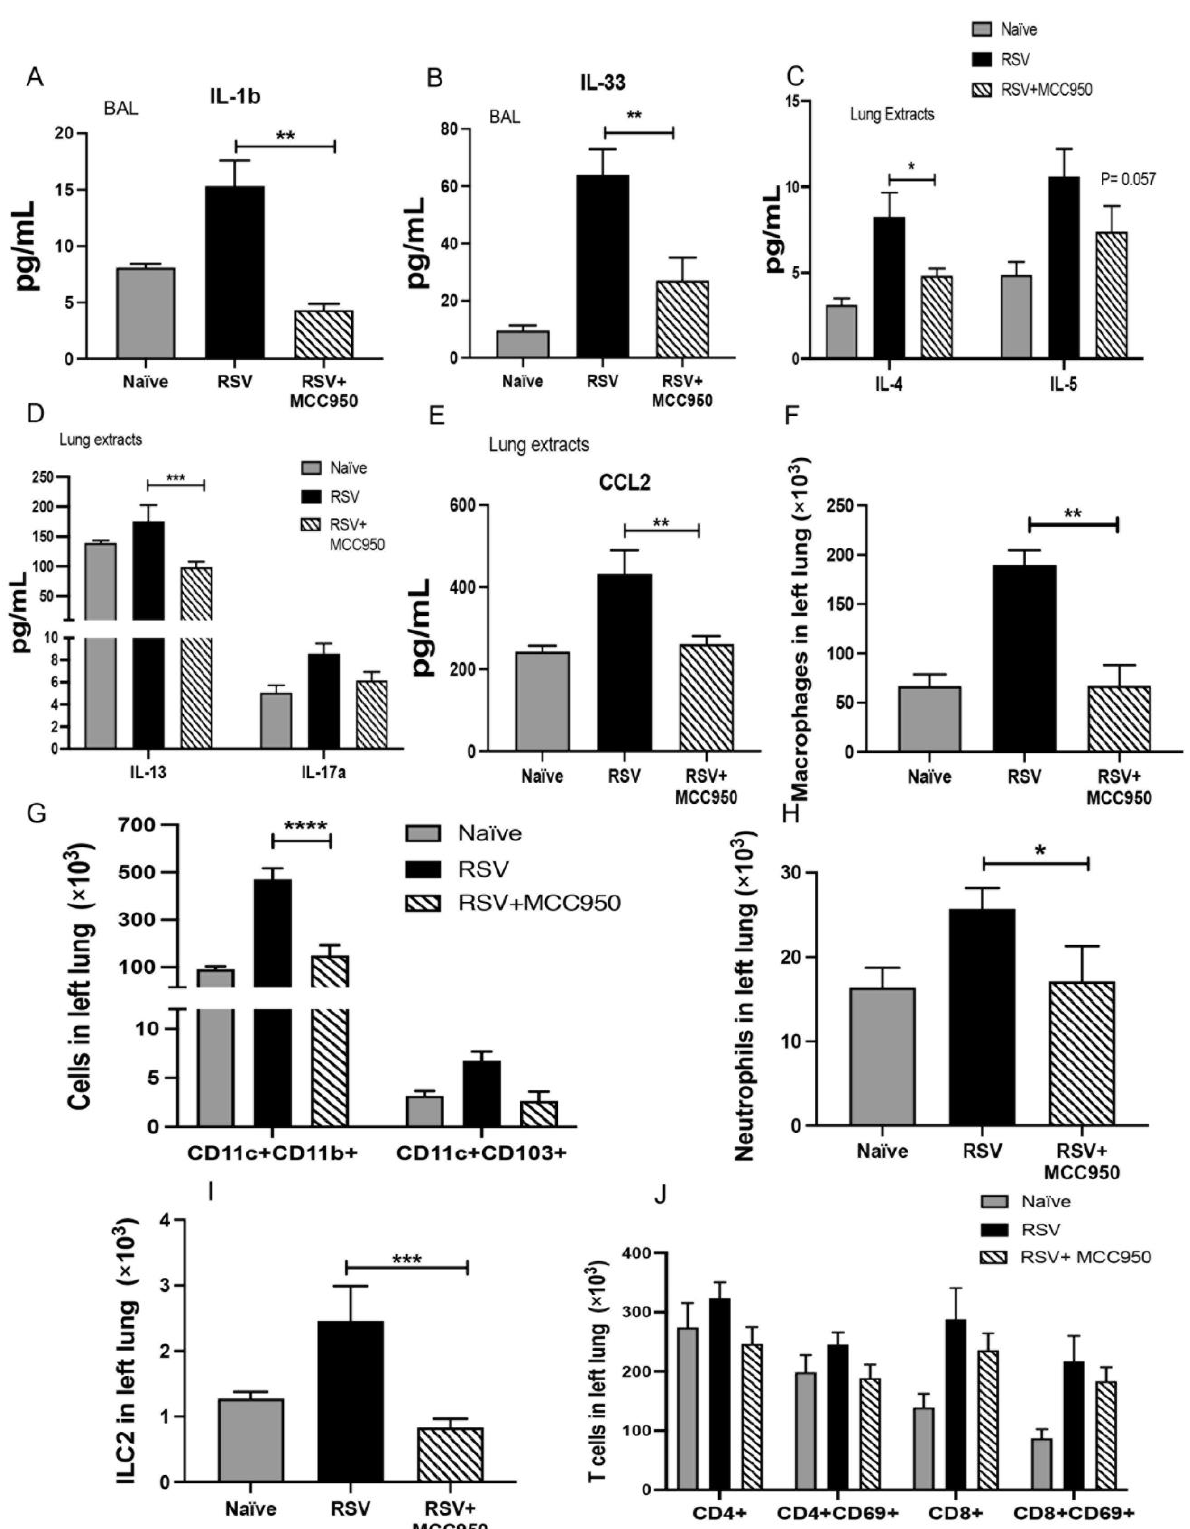
Figure 2. RSV immunopathology is dependent on NLRP3-inflammasome function Bronchoalveolar lavage (BAL) samples of adult mice were used to measure ( A ) IL-1β and ( B ) IL-33. Total lung extracts were used to evaluate levels of ( C ) IL-4 and IL-5, ( D ) IL-13 and IL-17 and ( E ) CCL2. ( F – J ) Flow cytometry of lung leukocytes. Data represent the Mean ± SEM from 4 to 5 mice (experimental repeats 2). * p ≤ 0.05, ** p ≤ 0.01, *** p ≤ 0.001, **** p ≤